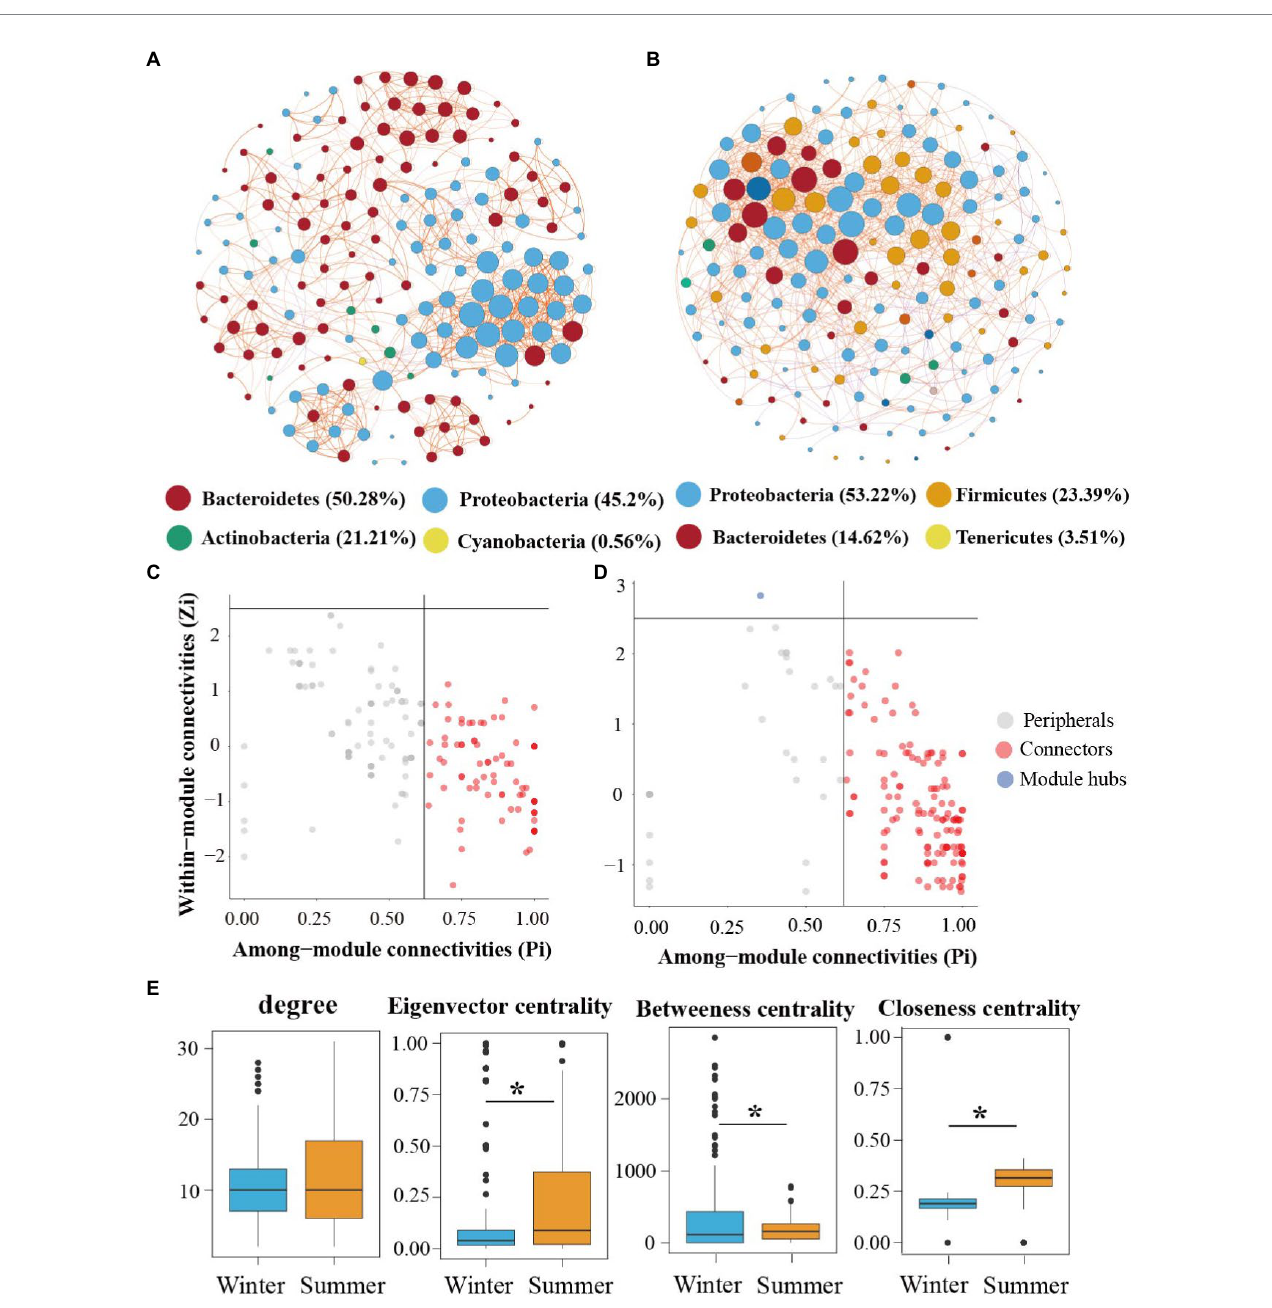
FIGURE 6 Network analysis of bacterial communities in subsidence lake and natural river. Networks analysis showing the bacterial community interspecies interactions in winter and summer (A,B) . The bacteria at the phylum level are colored by different color nodes. The size of the node presents the number of connections. The different color of edge color presents the positive (orange) and negative (purple) correlations of species. Identification of keystone taxa in (C) winter and (D) summer through their topological roles in networks. (E) The difference of topological features at node-level among two seasons network. Two comparisons with Wilcoxon tests, * p < 0.05, ** p < 0.01, *** p <